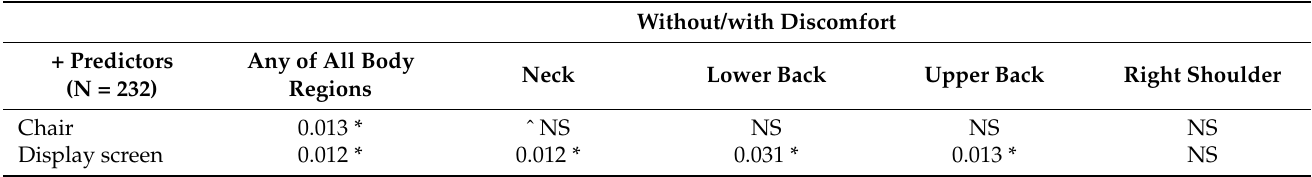
Table 11. Summarised results of home workstation setups factors associated with musculoskele- tal